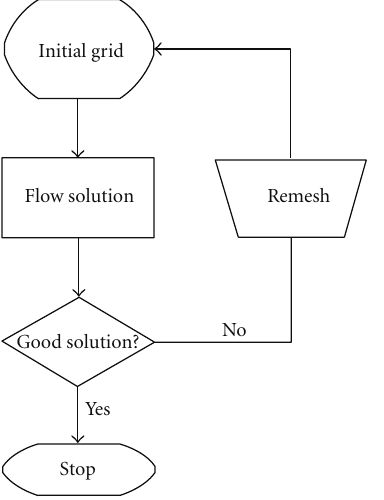
Figure 1: Manual adaptation process.